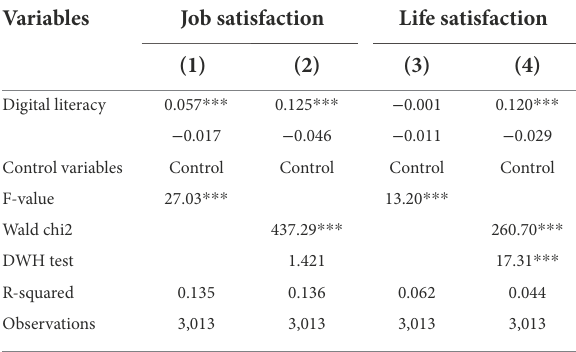
TABLE 8 Estimated results of how digital literacy affects different types of subjective